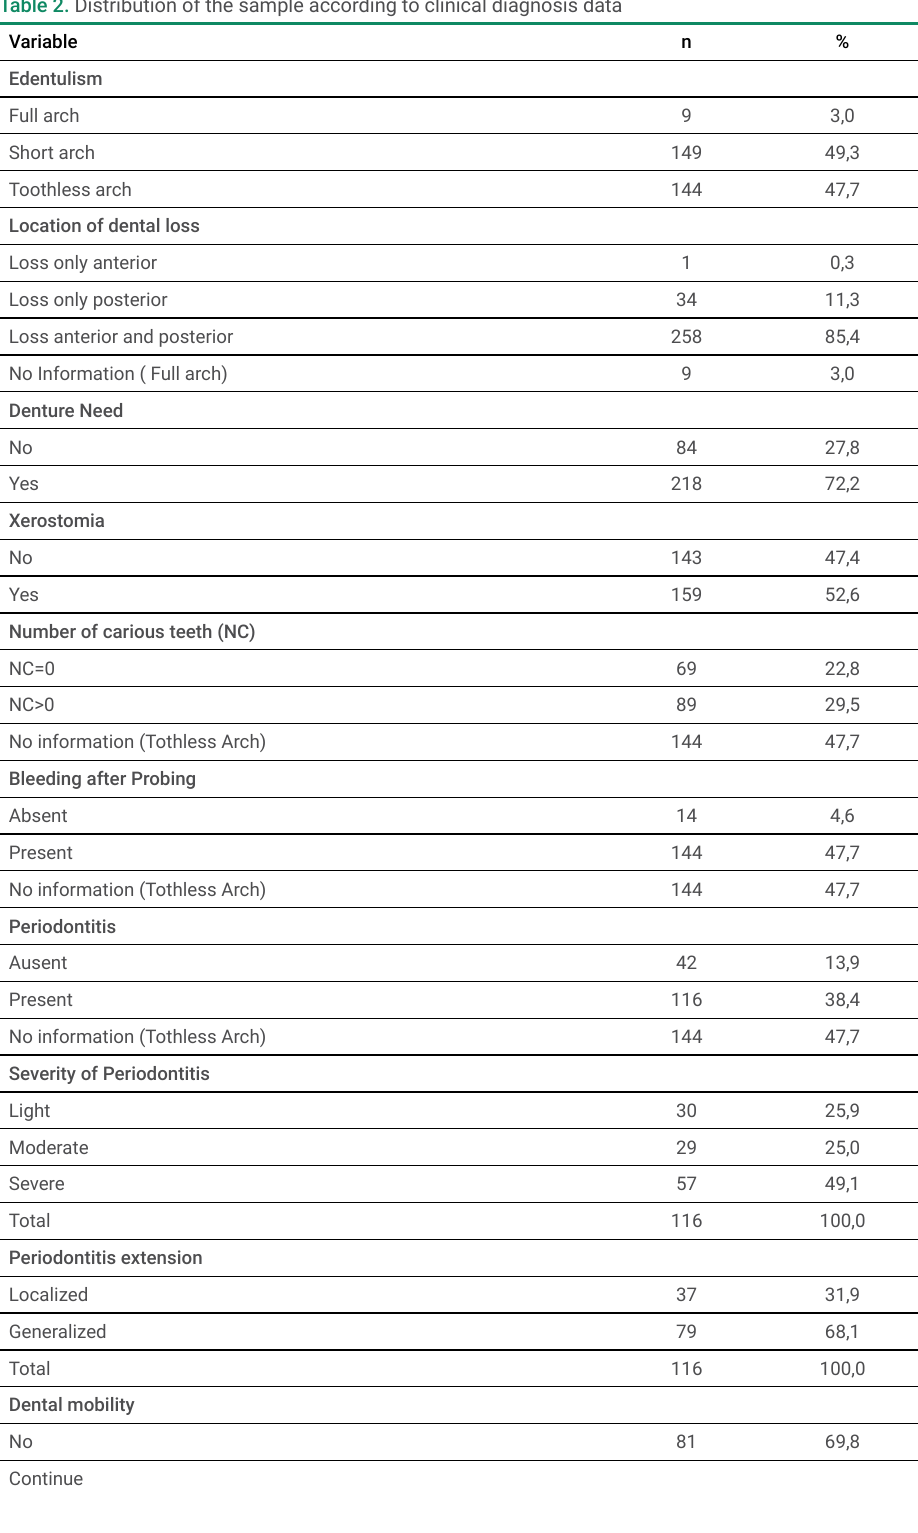
Table 2. Distribution of the sample according to clinical diagnosis data Variable